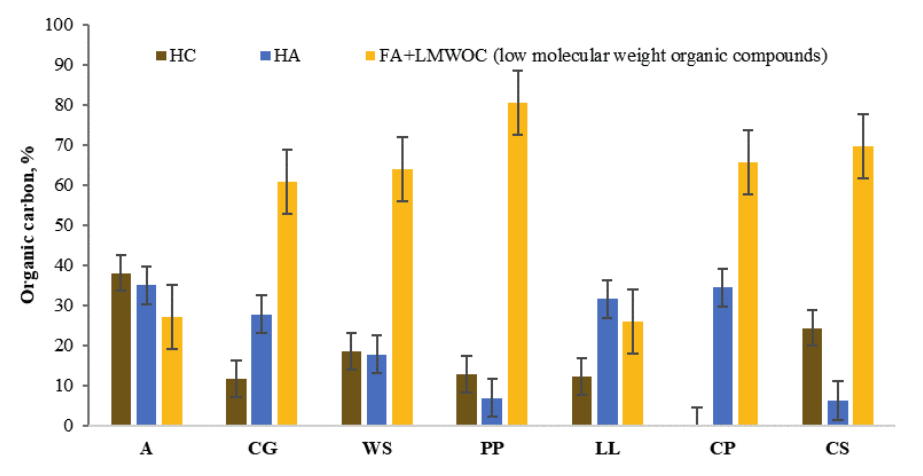
Fig. 5. Yield of hydrochar (HC), humic acids (HA) and fulvic acids + low molecular weight organic compounds (FA+LMWOC) depending on the type of biomass during hydrothermal carbonisation process (24 h, 200 °C, in presence of